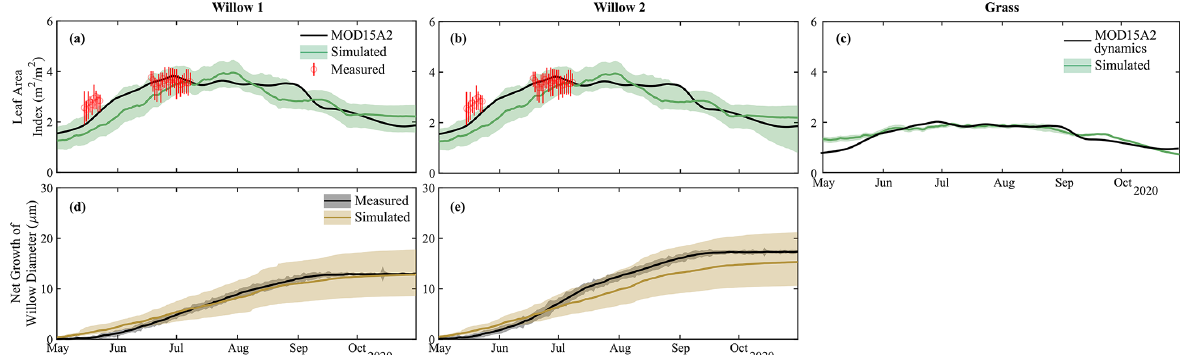
Figure 5. Simulated and measured leaf area index of (a) Willow 1, (b) Willow 2, and (c) grass and net growth of willow diameter of (d) Willow 1 and (e) Willow